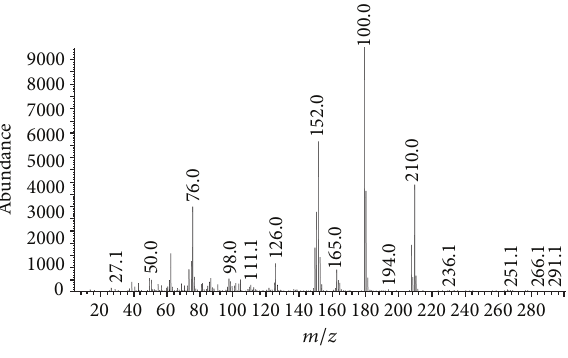
Figure 9: The mass spectrogram of 18.139